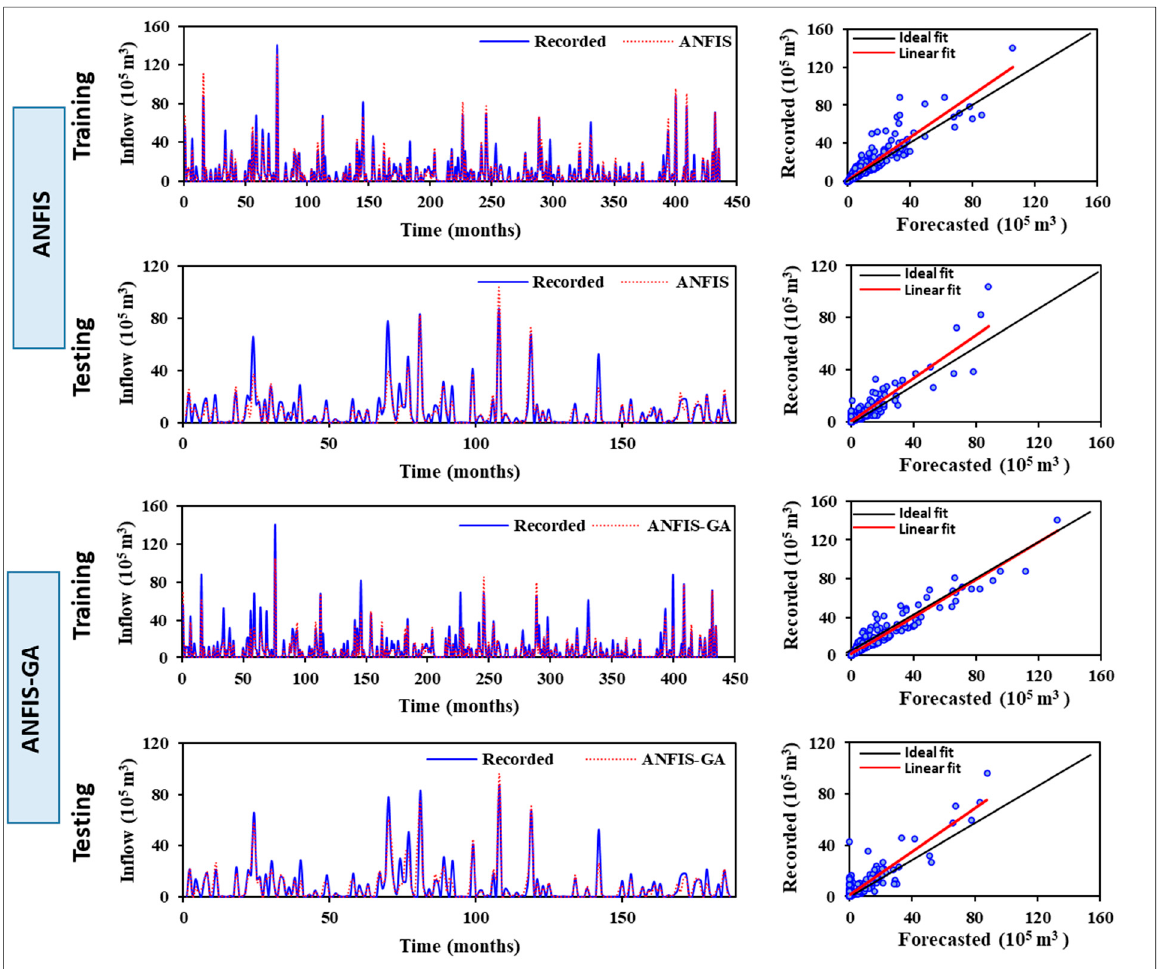
Figure 10. Training and testing results of the simulated monthly inflow based on the ANFIS and ANFIS-GA models.